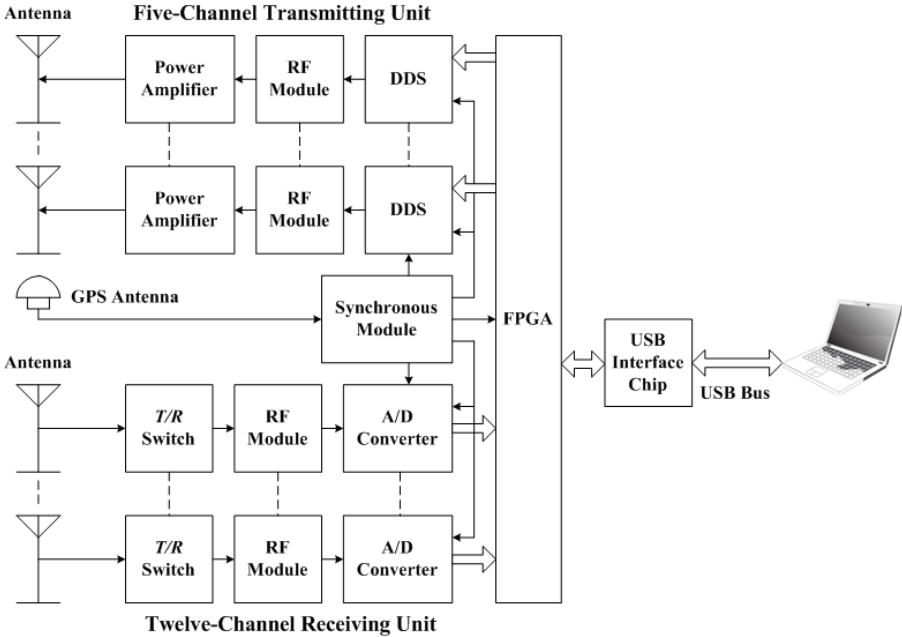
Figure 3. Block diagram of the latest version of WIOBSS.